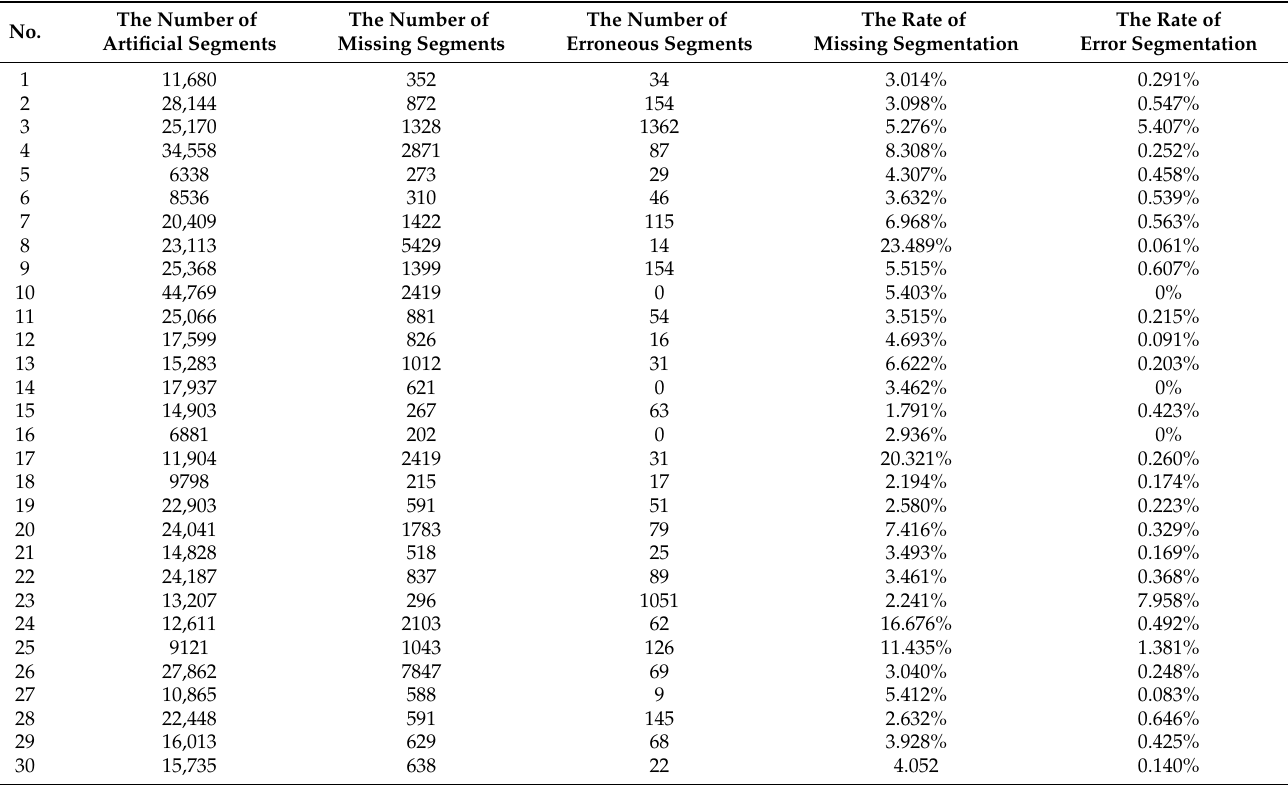
Table 2. The result of the segmentation of 30 images of long jujubes.